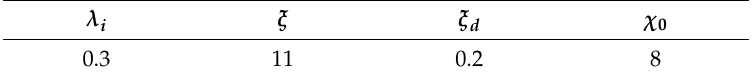
Table 4. Additional model parameters to include destructuration for Bothkennar clay.